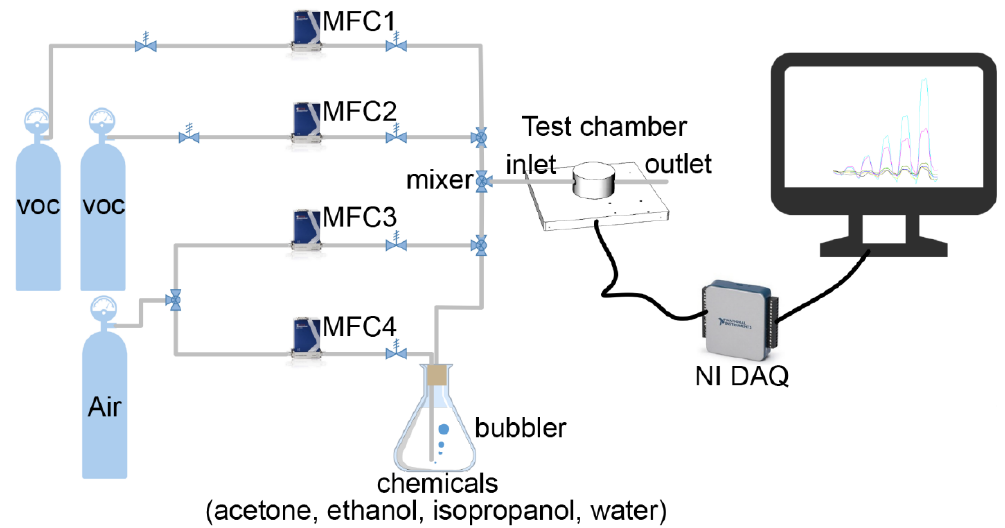
Figure 3. Schematic diagram of the experimental setup for gas sensing measurements.